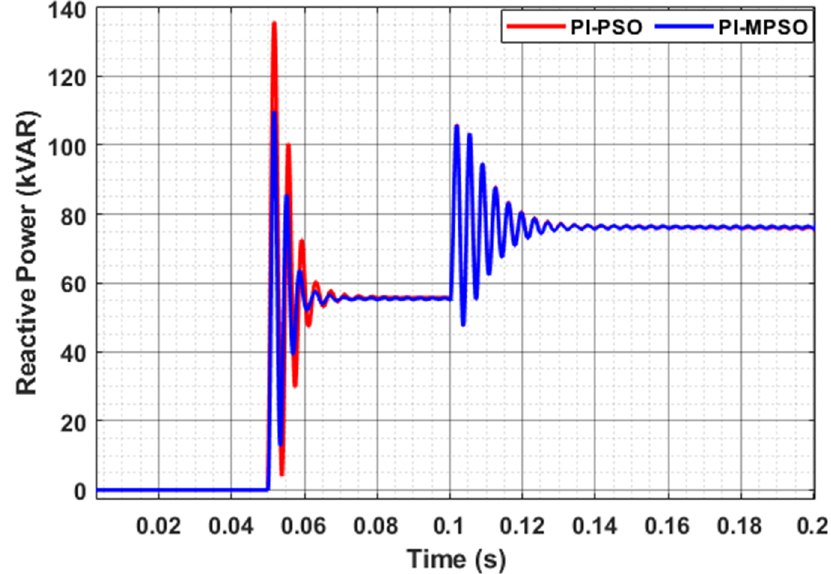
Figure 8. Reactive power comparison.